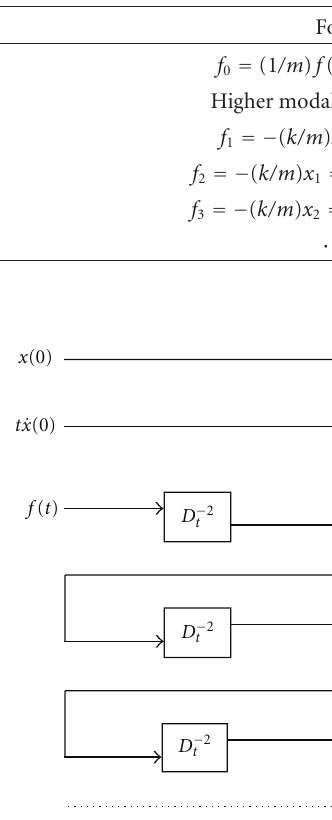
Table 1: Decomposing the action reaction of second-order mass-spring system.